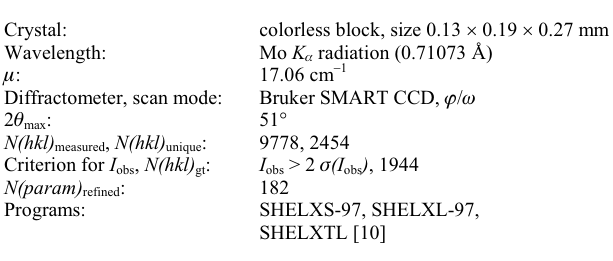
Table 1. Data collection and handling.